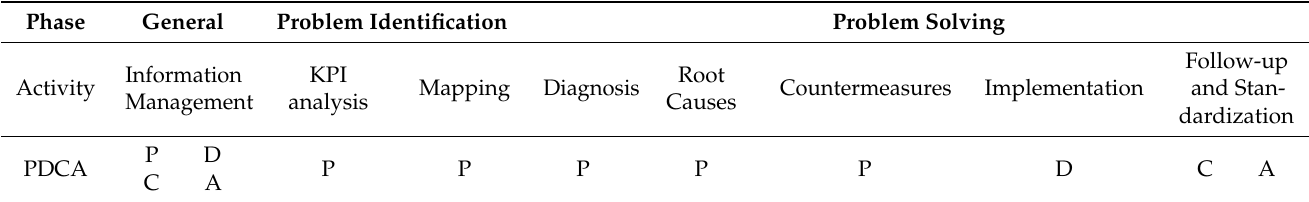
Table 1. Typical process for managing and executing CI projects.